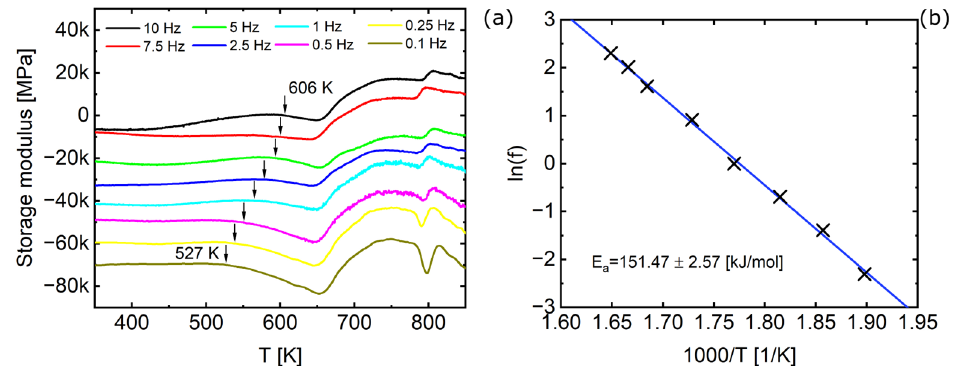
Figure 8. DMA measurements for Fe 81.2 Co 4 Si 0.5 B 9.5 P 4 Cu 0.8 before HPT deformation ( a ) Storage modulus measured by DMA with varying frequency (0.1–10 Hz) at a heating rate of 10 K/min (only selected numeric values given due to visibility) ( b ) Arrhenius plot of the glass transitions from Figure 8a for the determination of the activation enthalpy of the glass transition.